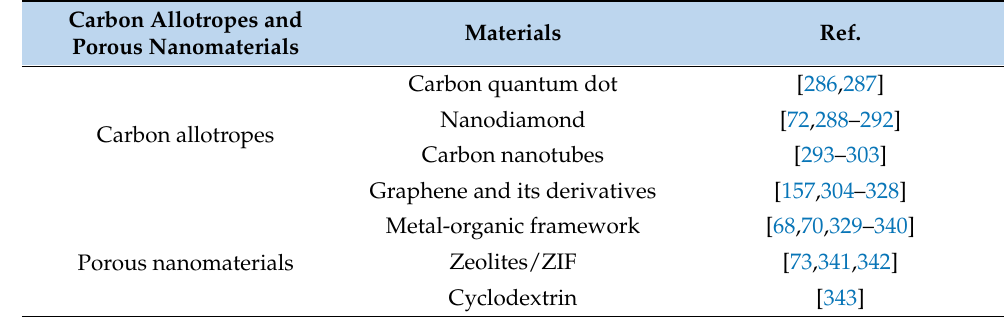
Table 4. Carbon allotropes and porous nanomaterial as antifouling additives used in the last 10 years for the blending modification of polymeric